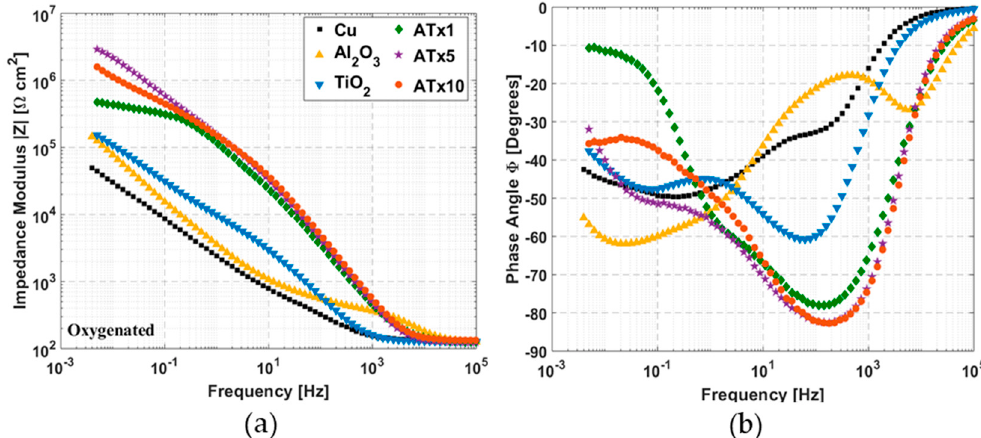
Figure 6. Impedance spectra measured from 100 kHz to 5 mHz in oxygenated 0.1 M NaCl at OCP: ( a ) impedance modulus and ( b ) phase angle versus frequency. Refer to Table 1 for sample descriptions.